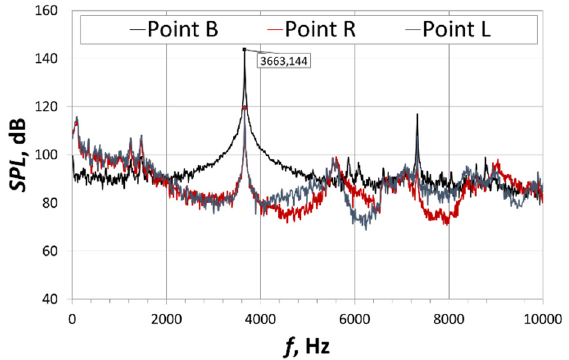
Figure 20. Spectral analysis of SPL for velocity equal to 70 m/s—CFD.